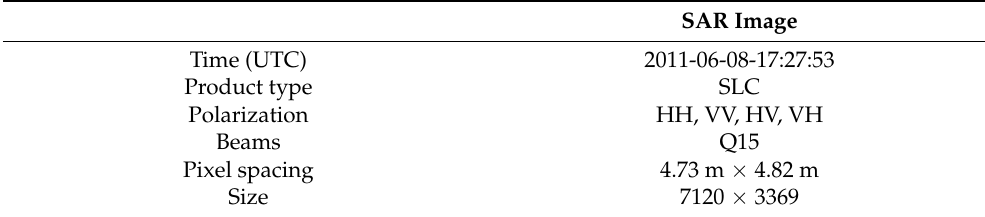
Table 6. Details information on the image acquisition by RADARSAT-2 used in this study.